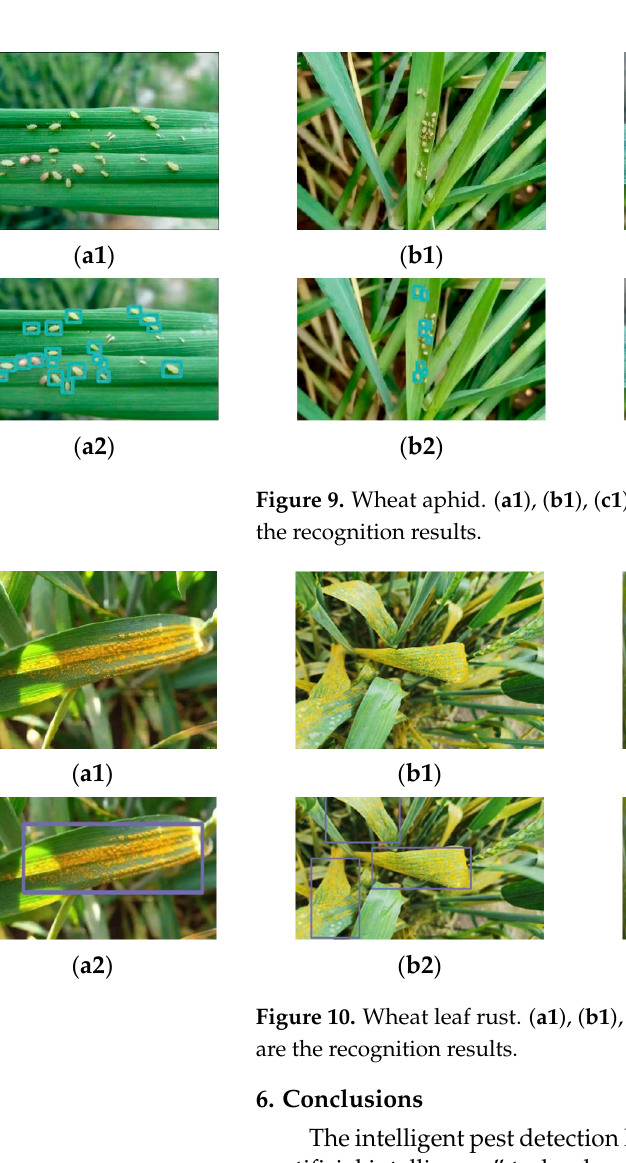
Figure 10. Wheat leaf rust. ( a1 ), ( b1 ), ( c1 ), and ( d1 ) are the original images; ( a2 ), ( b2 ), ( c2 ), and ( d2 ) are the recognition results.